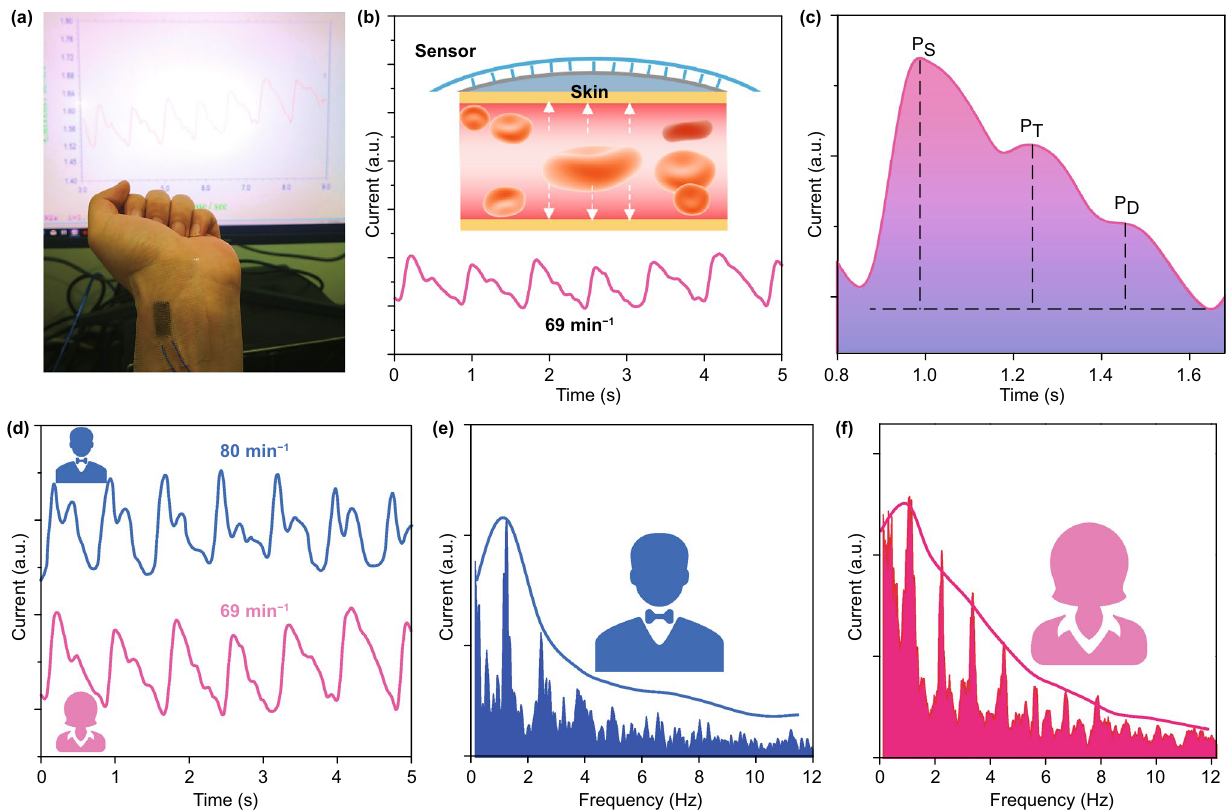
Fig. 5 Pulse rate monitoring of the flexible sensor. a The flexible sensor was well mounted onto our body to monitor the pulse rate. b ‑ c Prin‑ ciple and practical application of the sensor on successfully detecting the pulse rate. d ‑ f The sensor was able to identify different person’s pulse